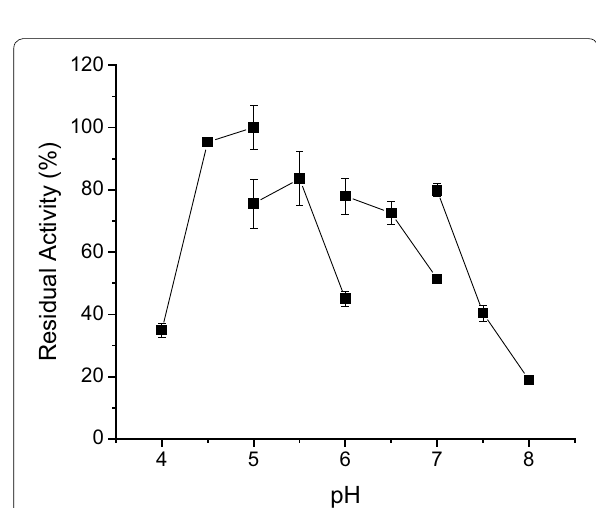
Fig. 4 Effects of pH on the specific activity of AfPase. The reactions were performed in 100 mM glycine–HCl buffer (pH 4.0–5.0), acetic acid–acetate sodium buffer (pH 5.0–6.0), Bis–Tris buffer (pH 6.0–7.0), HEPES buffer (pH 7.0–8.0) containing 1 mM p -nitrophenyl phosphate, 5 mM MgCl 2, and appropriate concentration of phosphatase at 85